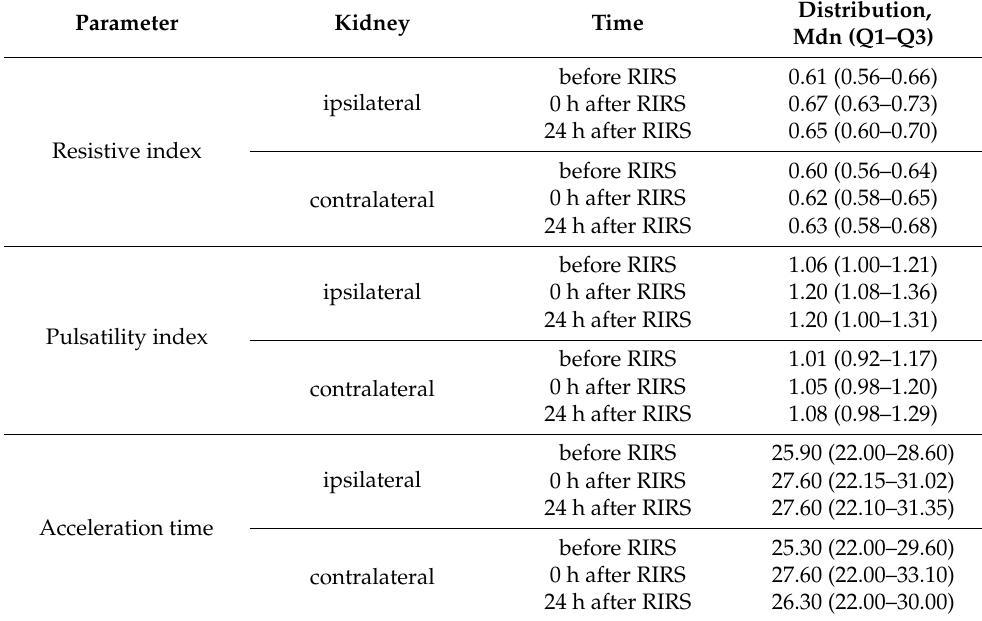
Table 3. Characteristics of the clinical data with repeated measures, N obs = 55.